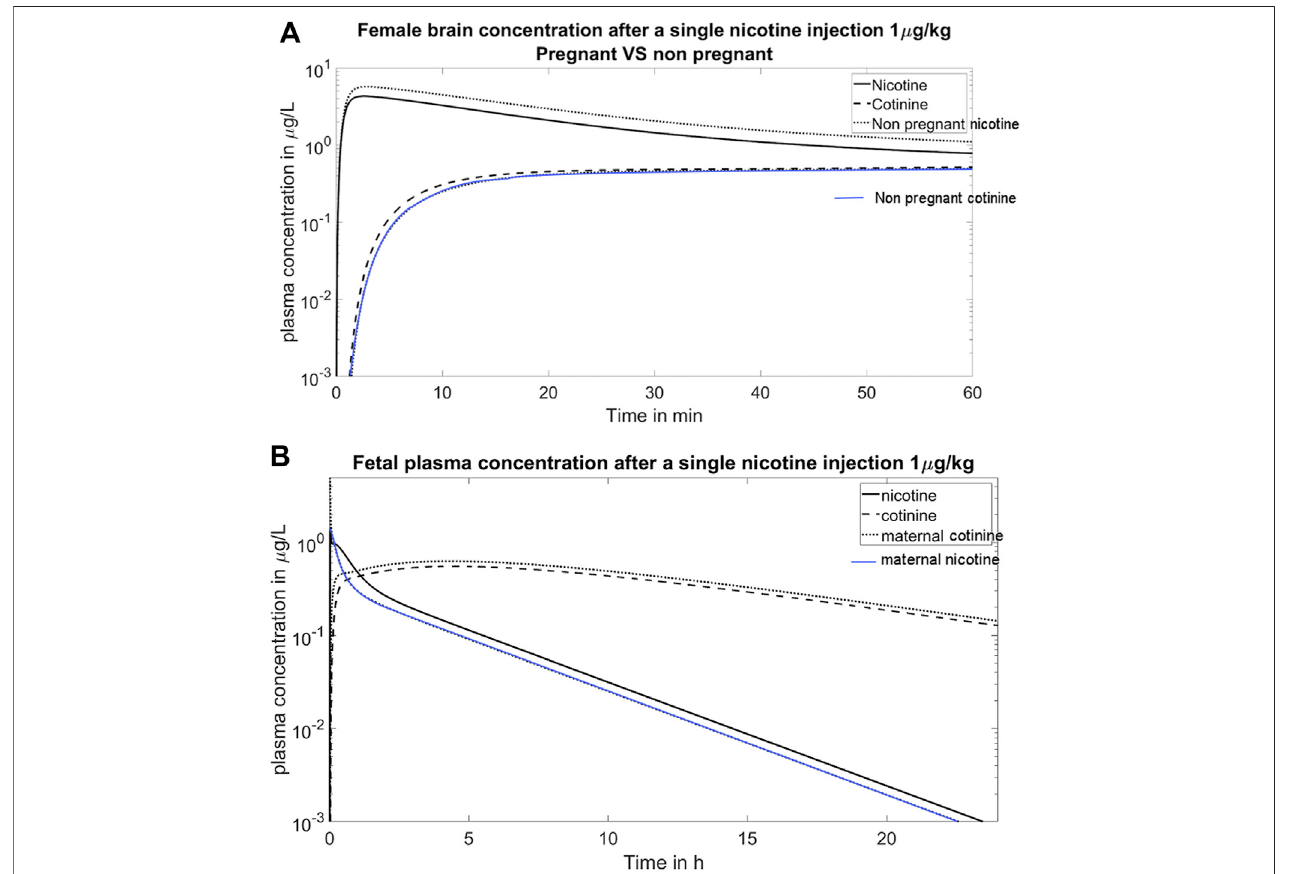
FIGURE 3 | (A) Simulation of the time course of the concentration of nicotine and cotinine in the maternal brain. The nicotine enters brain quickly and reaches its peak value within 2 min. This fi gure also shows the higher clearance of nicotine in pregnant women than in non-pregnant women; (B) Simulation of fetal plasma concentration after a single nicotine injection 1 μ g/kg. The simulation reproduces the clinical observation that the fetal nicotine level is higher than the maternal nicotine level, yet the fetal cotinine level is lower than the maternal level (Lambers and Clark, 1996).